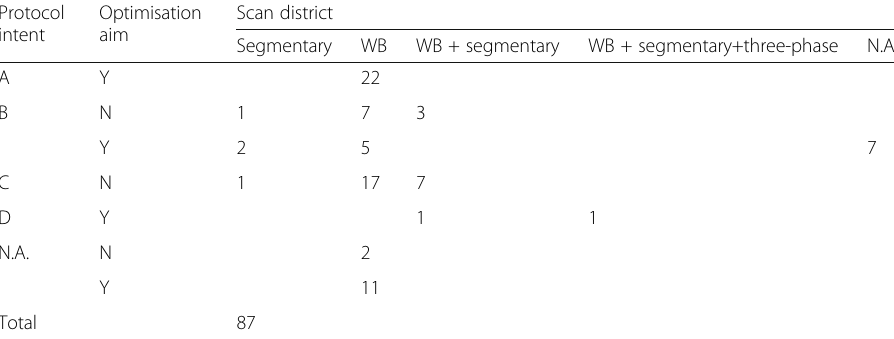
Table 7 Optimisation aim distribution per protocol intent and scan